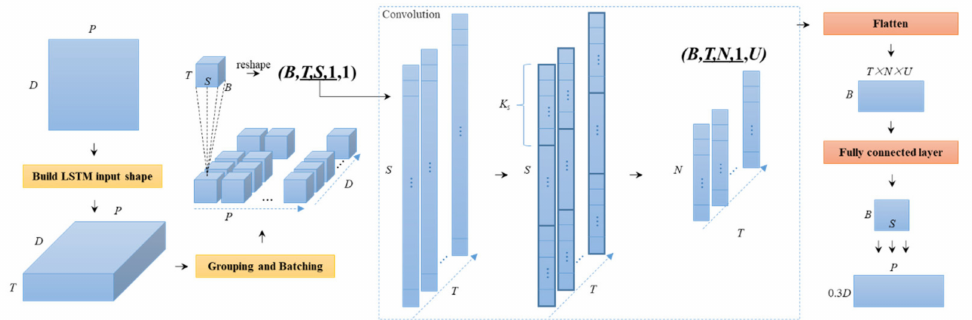
Figure 1. The structure of the